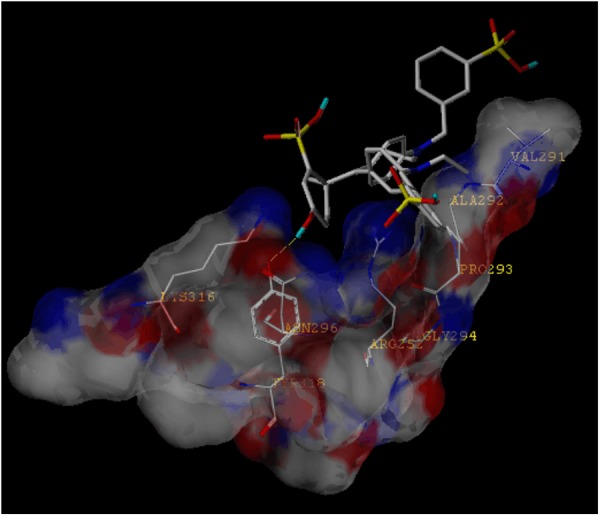
Molecular docking simulation of the interaction between FGF and the P2X4 receptor. The low-energy conformation of fast green bound to P2X4 ion channel generated by molecular docking. FGF is depicted as a stick model showing carbon (white), oxygen (red), nitrogen (dark blue), sulfate (yellow), and hydrogen (light blue). Yellow dash lines represent hydrogen bonds.